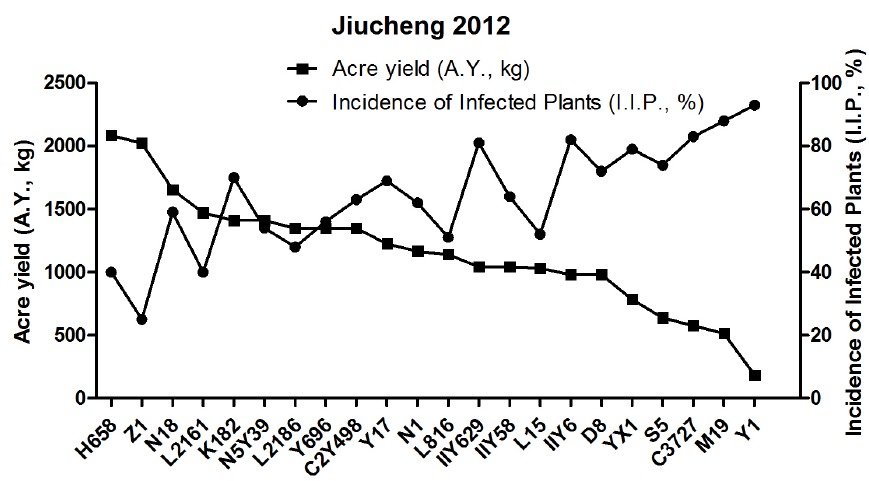
Figure 1. Correlation between incidence of infected plants (I.I.P., %) and acre yield (A.Y., kg) of 22 rice varieties in the 2012 field test.